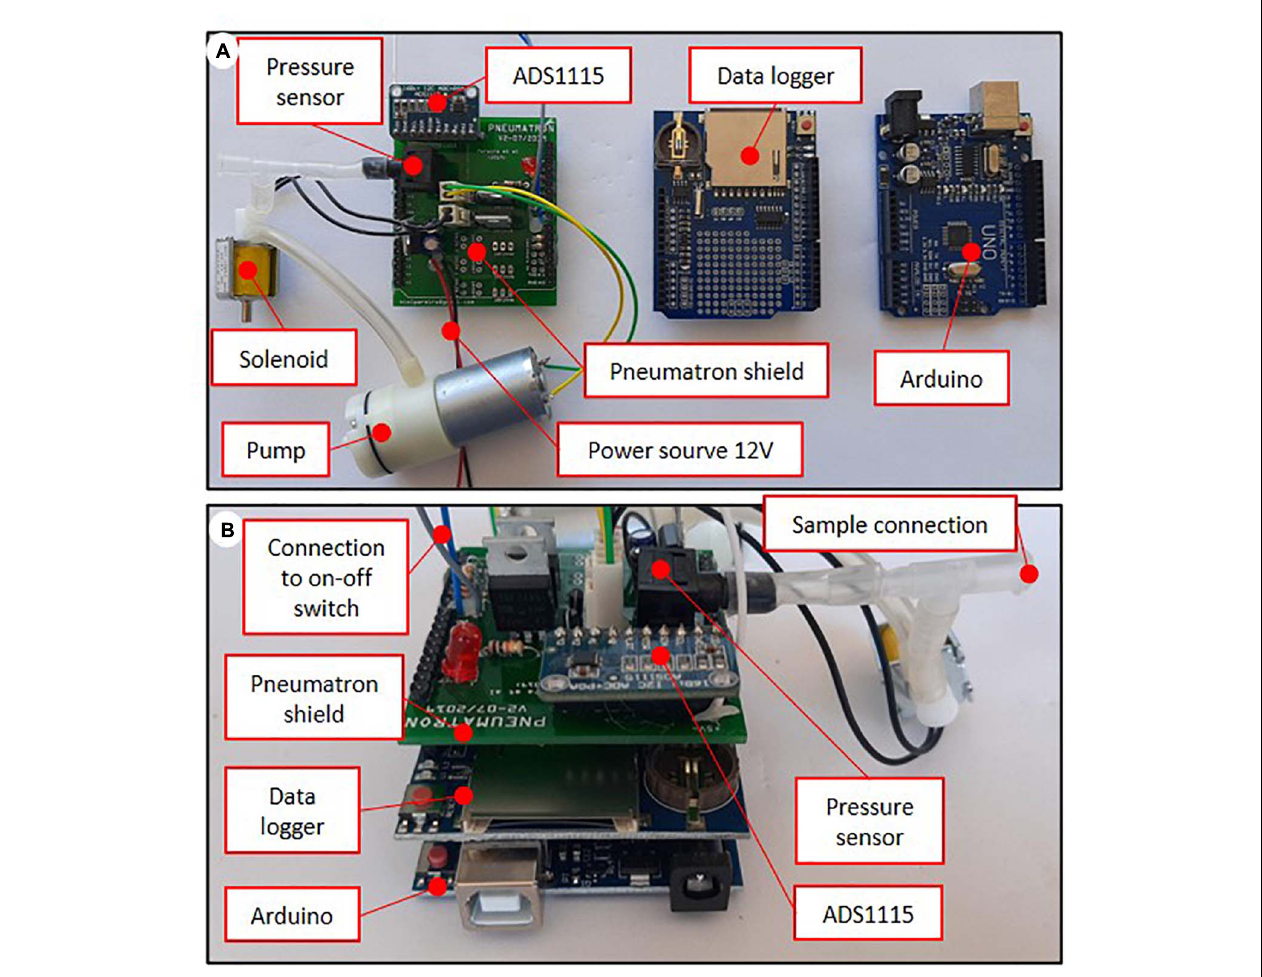
FIGURE 2 | Components and connections (A) , and assembling position (B) of the Pneumatron with a Pneumatron shield (in which the switch and power source were connected using